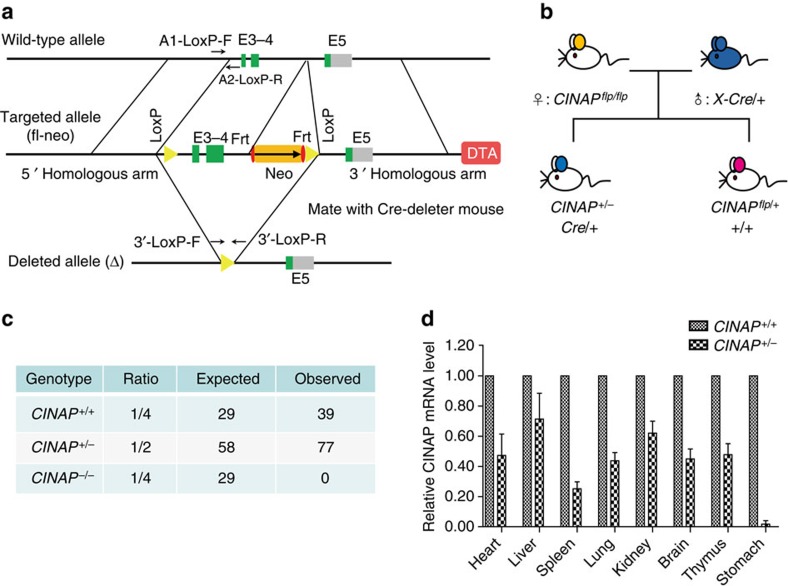
Disruption of CINAP results in embryonic lethality.(a) Schematic diagram of the CINAP locus and the targeting construct. The targeting vector replaced exons 3 and 4 with a neomycin-selectable marker flanked by LoxP sites. (b) CINAPflp/flp mice (8 weeks of age, female, n=2) were crossed with X-linked CMV-Cre mice (BALB/c, 8 weeks of age, male, n=1) to generate CINAP-deleted mice. (c) Observed and excepted birth ratio from CINAP+/− intercrosses (n=116). (d) Quantitative PCR analysis of CINAP expression in organs from adult CINAP+/+ and CINAP+/− mice (female, 8 week of age, n=3 for each genotype, randomly selected). Results are presented as mean±s.d. Killing of mice was performed according to the ethical guidelines approved by Peking University Laboratory Animal Center.